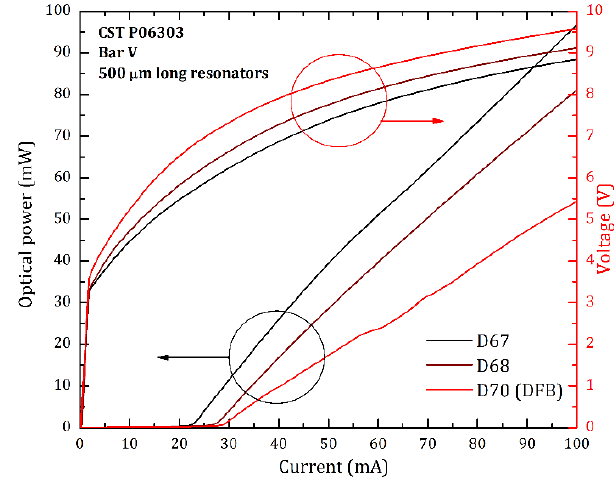
Figure 11. LI characteristics of a FP GaN LD versus a third-order DFB GaN LD.